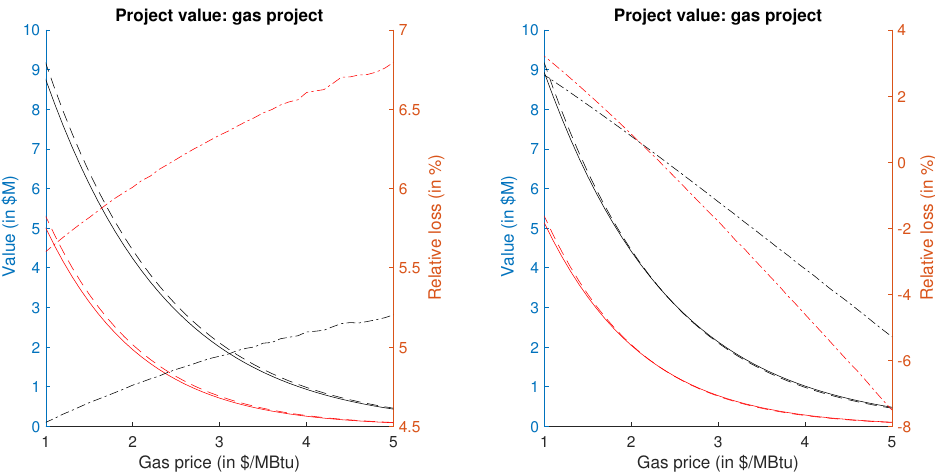
Figure 4. This figure displays the value function ( left scale ) and the relative loss in project value (dot-dashed on right scale ) for the gas-fired plant at t = 0 (black) and t = 0.3 (red) in case of low sensitivity of the gas price ( C = 0, left panel) and of high sensitivity ( C = 2.5, right panel ). The value of X t is 50$/MWh. Solid line corresponds to the pandemic case, dashed line to the no-pandemic case. Parameter values are given in Table 1; the investment horizon is T = 1